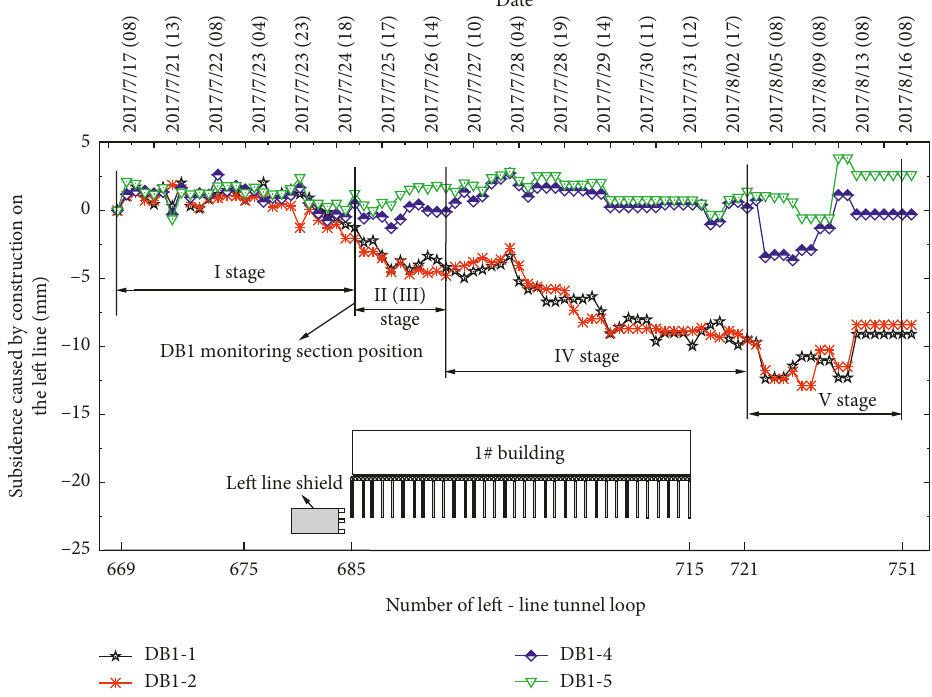
Figure 8: Monitoring time-history curve of surface subsidence of section